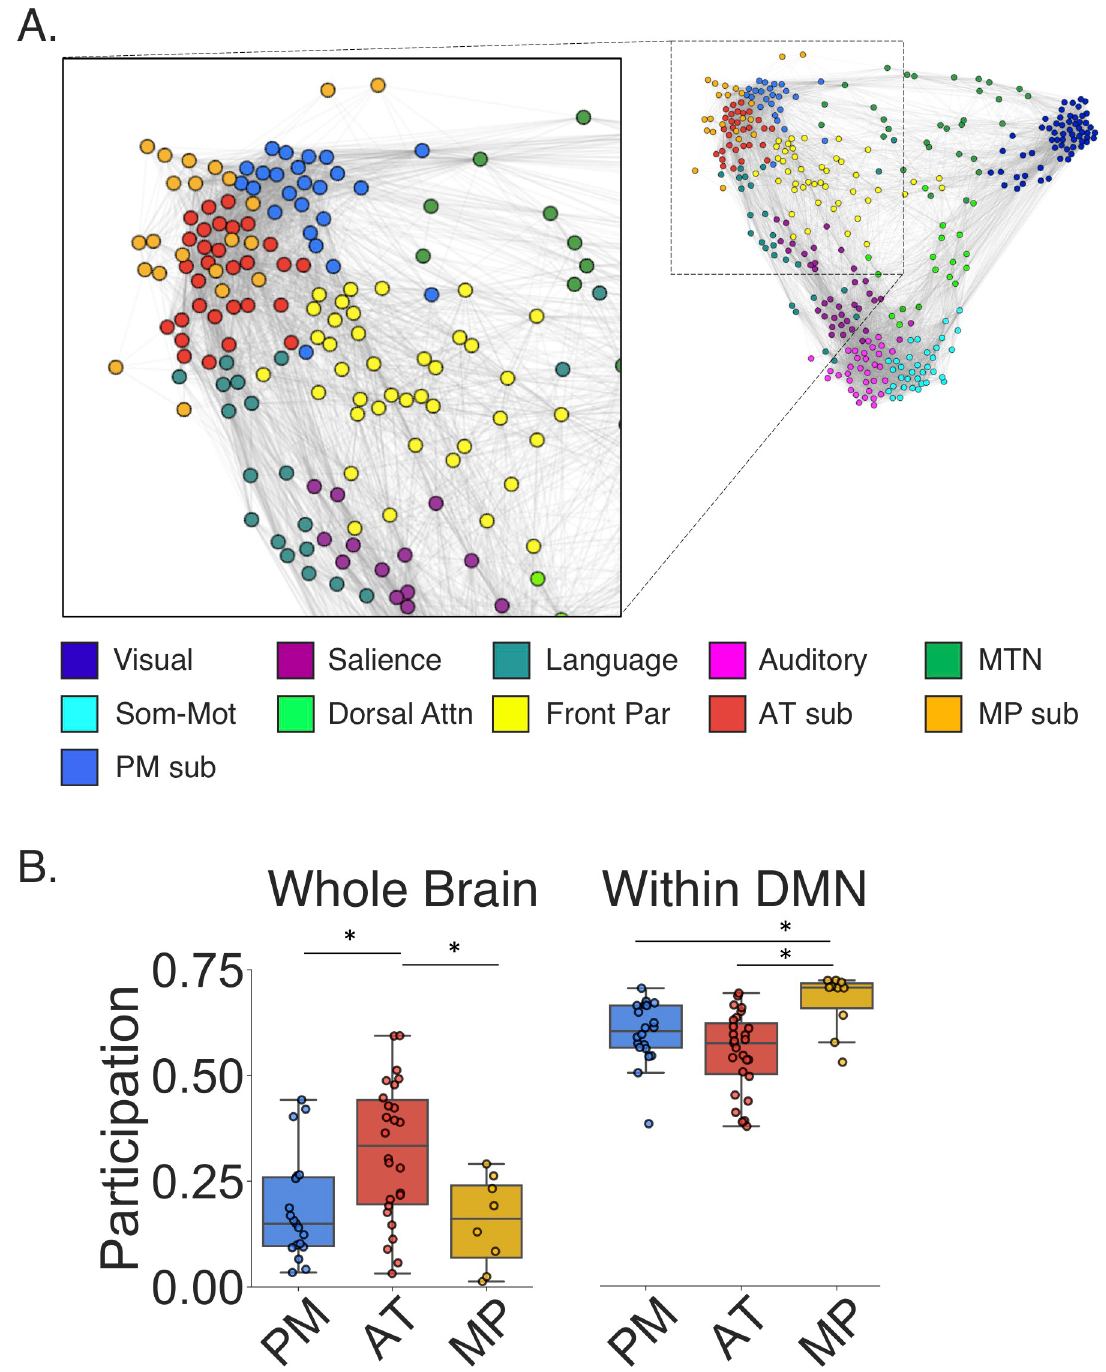
Fig 4. DMN subnetworks interact with language, frontoparietal, and MTNs. (A) Force-directed graph of the group-averaged networks with the DMN relabeled according to subnetwork membership. (B) Boxplots showing participation coefficient for DMN nodes to the rest of the brain (Whole Brain) and participation coefficient for DMN nodes to subnetworks of the DMN (Within DMN). AT, anterior temporal; Attn, attention; DMN, default mode network; Front Par, frontoparietal; MP, medial prefrontal; MTN, medial temporal network; PM, posterior medial; Som-Mot, somatomotor. � indicates significant difference at p < 0.05. Data can be found at https://github.com/ajbarn/hippo_nets.